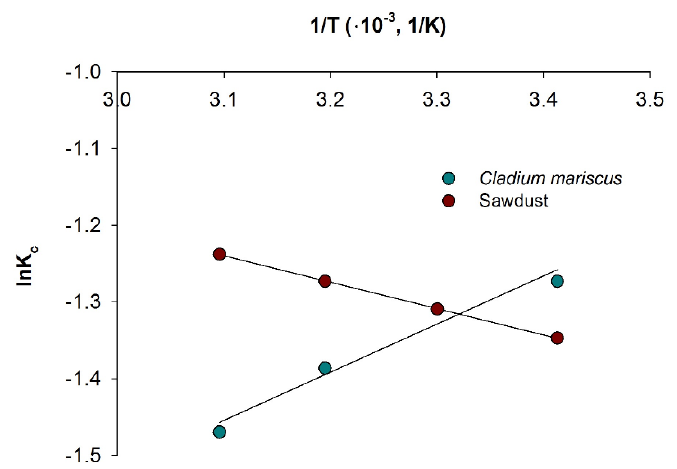
Figure 9. Estimation of thermodynamic parameters for the adsorption of BB3 onto sawdust and Cladium mariscus saw-sedge. Table 6. Thermodynamic parameters of BB3 adsorption onto sawdust and Cladium mariscus